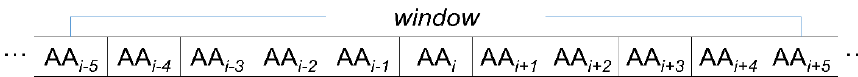
Figure 6. Sequence neighbors of amino acid AA i .